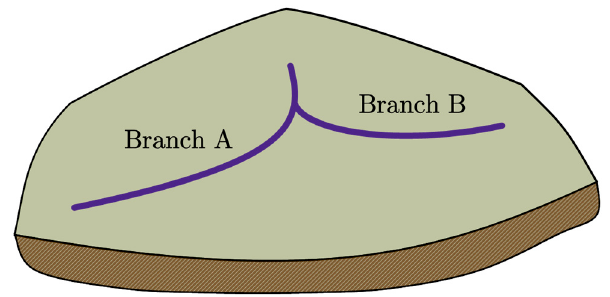
Figure 10. Multilateral well in single-layer reservoirs with large area.